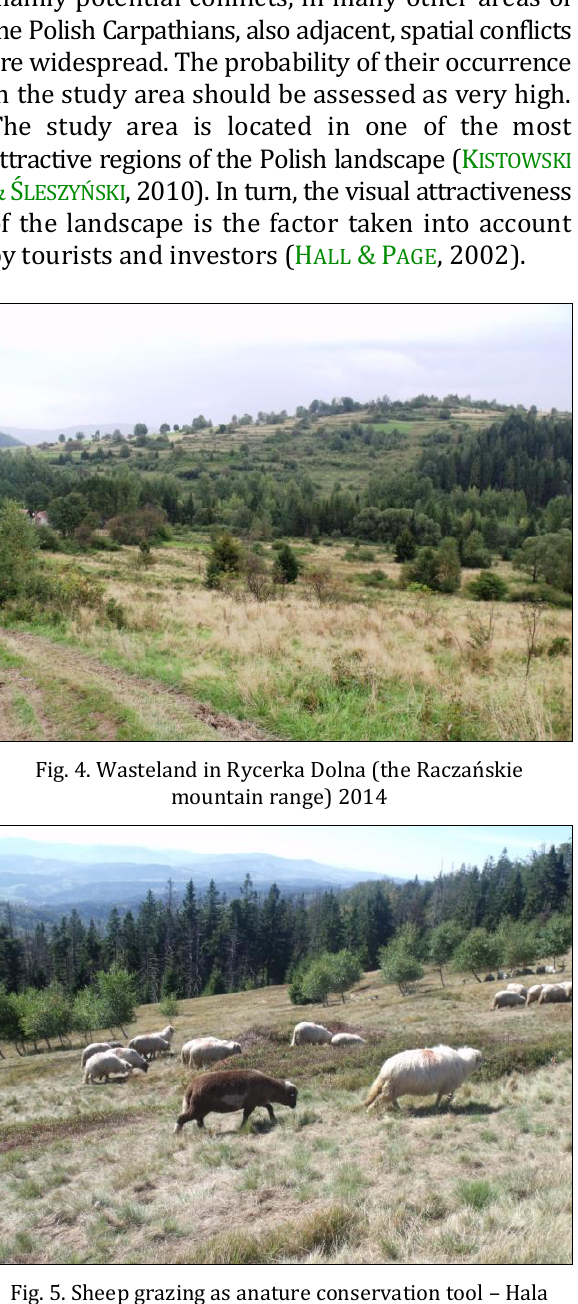
Fig. 5. Sheep grazing as anature conservation tool – Hala Radziechowska (the Wiślańskie mountain range)